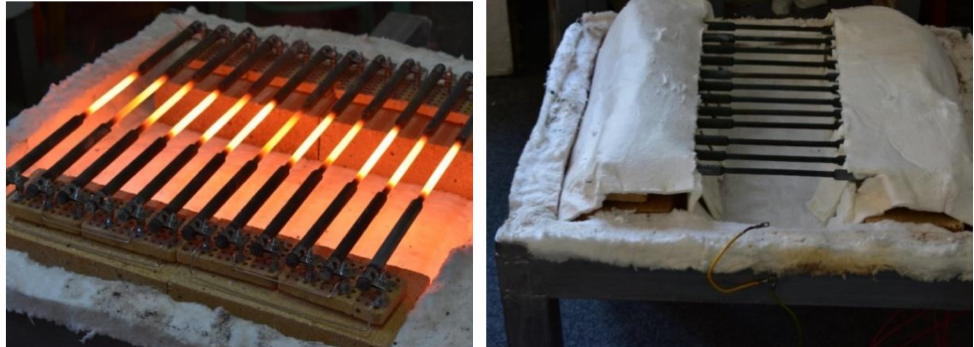
Figure 4. Silite bars/rods during operation, and their thermal insulation.